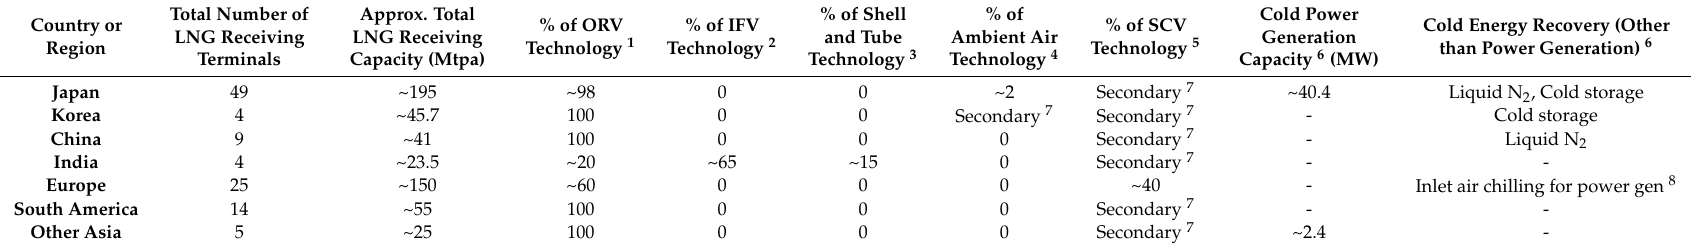
Table 1. Liquefied natural gas (LNG) regasification technologies: a global summary position